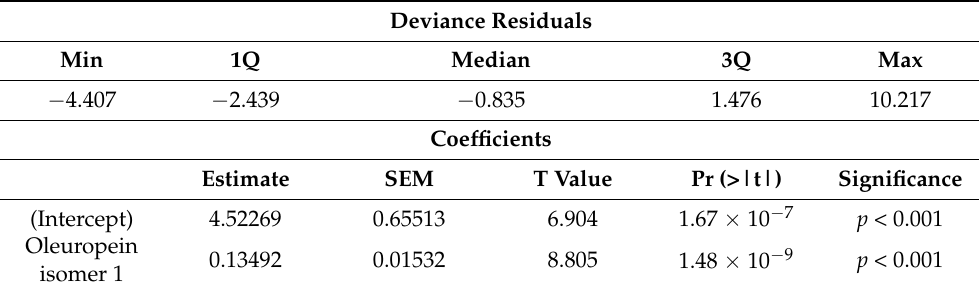
Table 2. GLM 1 summary (antioxidant capacity, TEAC).